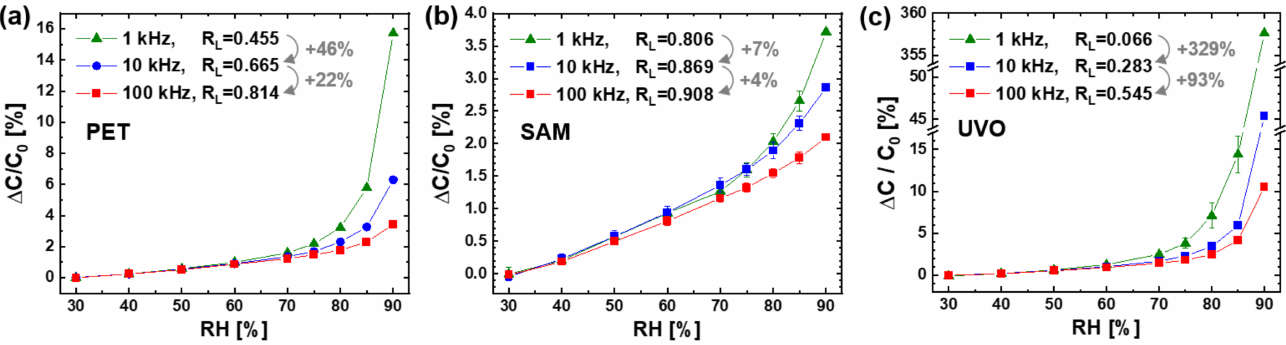
Figure 5. Humidity response of the PET sensors at different operating frequencies (1, 10, 100 kHz): ( a ) before surface treatment, ( b ) after the SAM coating, and ( c ) after the UVO